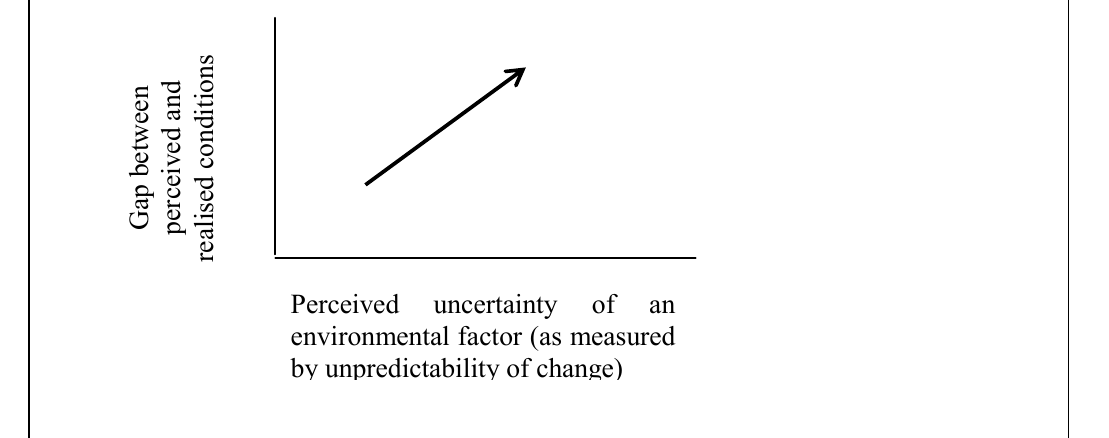
Figure 5: Relationship between perceived uncertainty and gap between perceived and realised